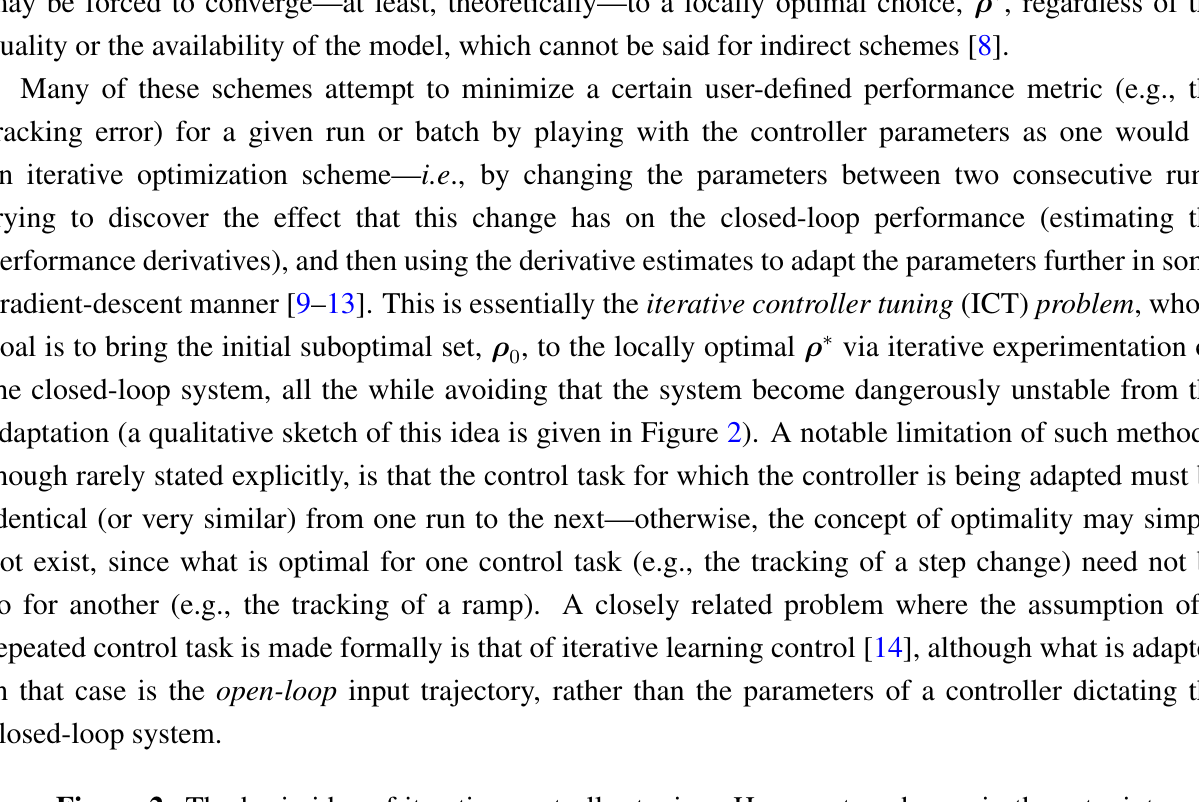
to denote a sort of “anti-optimum” that (cid:3)